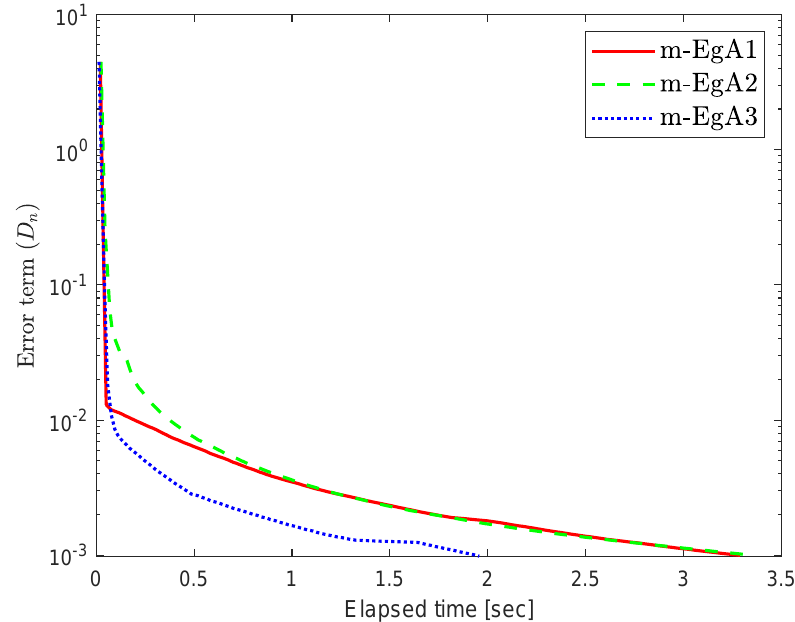
Figure 6. Numerical behaviour of Algorithm 1 compared to Algorithm 1 in [30] and Algorithm 2 in [30] for Example 1, when m =